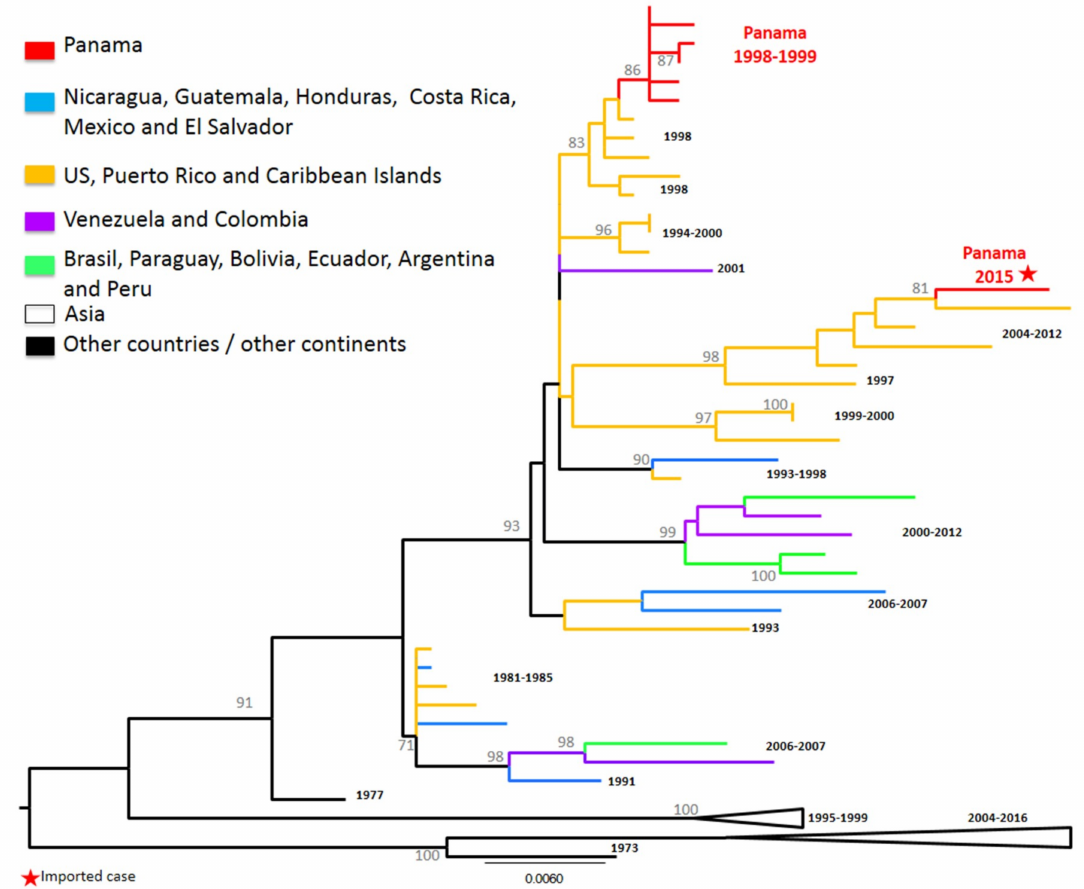
Figure 5. Denv-4 phylogenetic tree. Maximum Likelihood tree (ML) of Dengue virus 4 complete envelope (E) protein genes. The ML tree was constructed based on the model Hasegawa–Kishino–Yano, with bootstrap values (1000 replicates). Purple color represents DENV-4 Panamanian strains ( n =